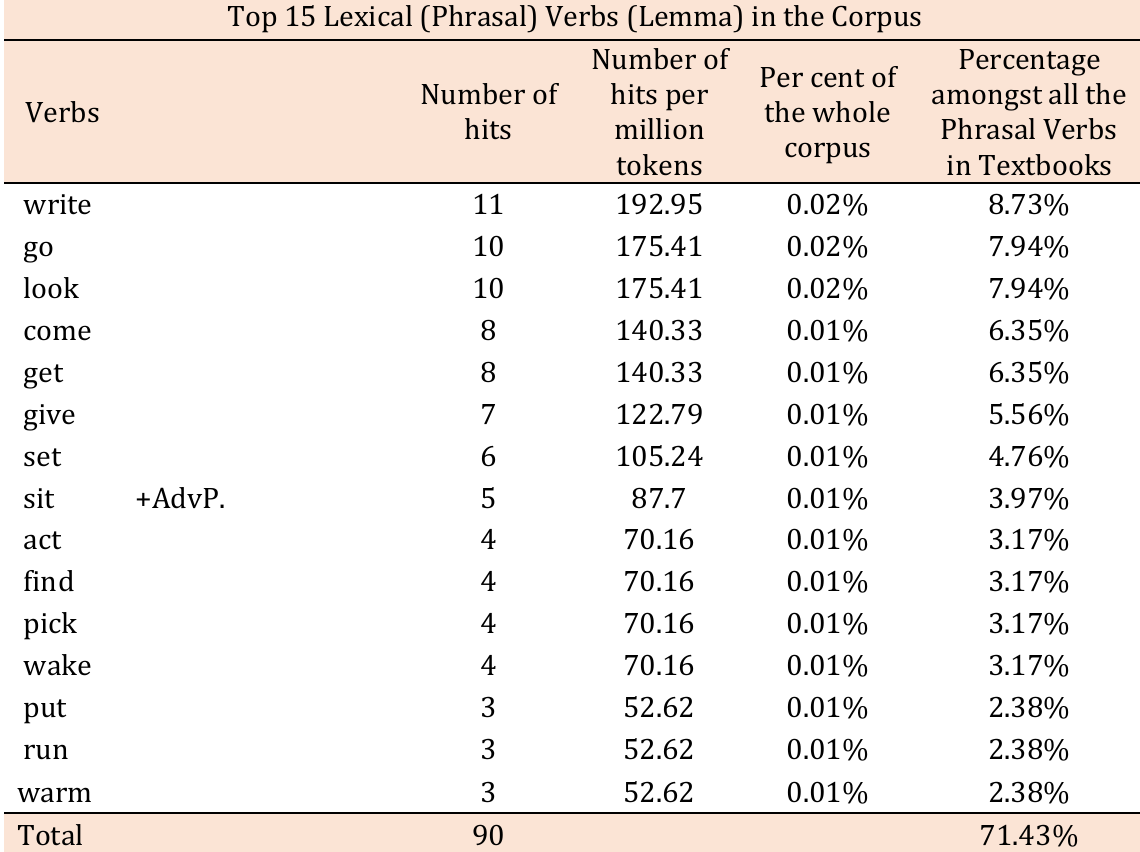
Table 3. The top fifteen (15) lexical PVs (lemmas) and their data in the current textbook corpus Top 15 Lexical (Phrasal) Verbs (Lemma) in the